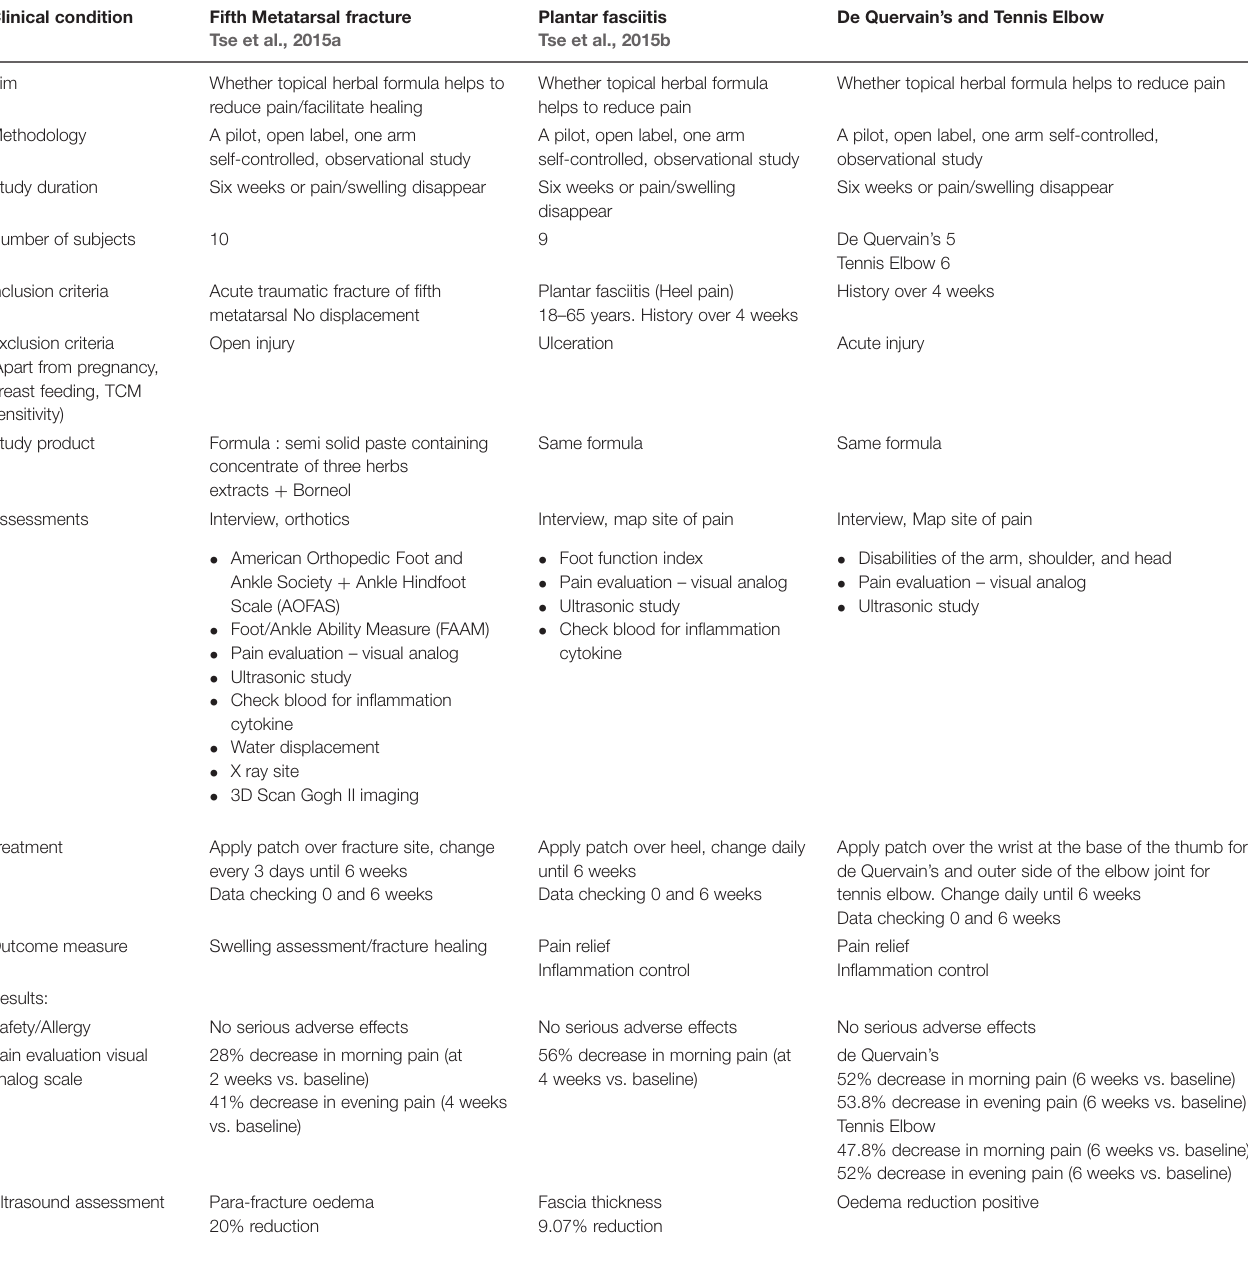
TABLE 1 | Summary of three pilot studies using the topical herbal application. Clinical